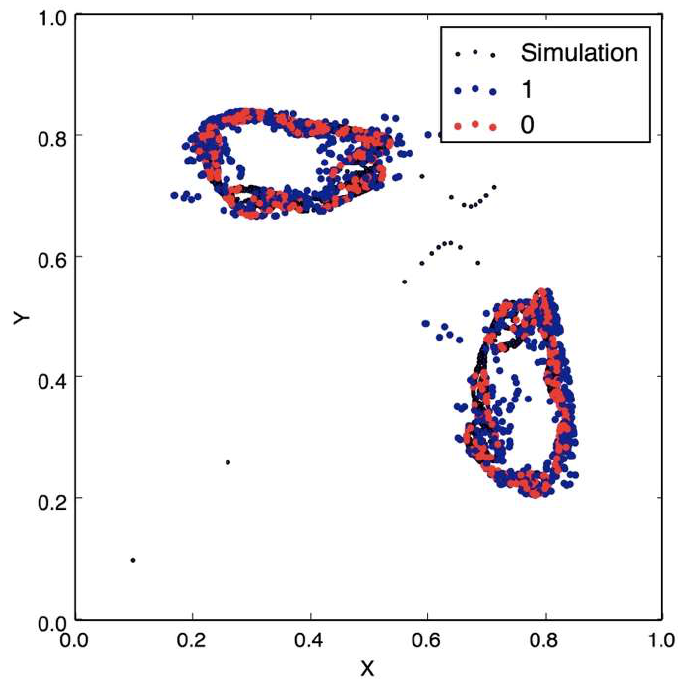
Figure 4. A longer message over the full dynamic of Figure 2.